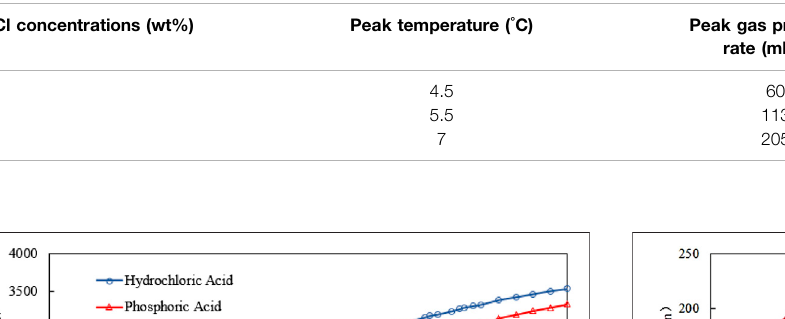
TABLE 3 | Experimental data for scenario 2.